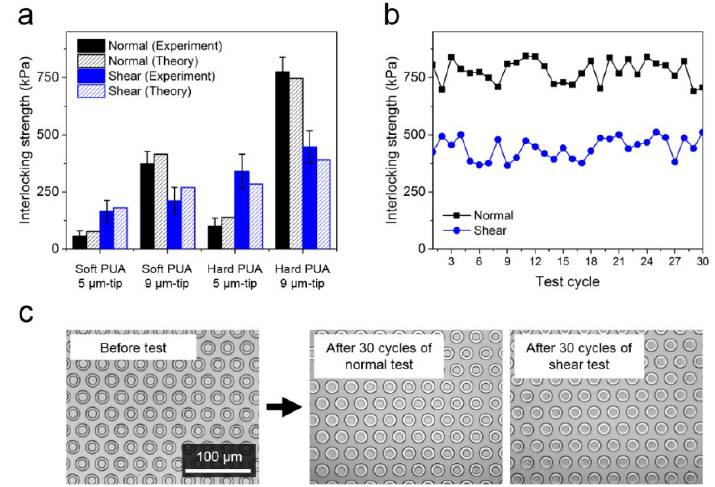
Table 1. Mechanical properties of soft and hard PUA [19–21].